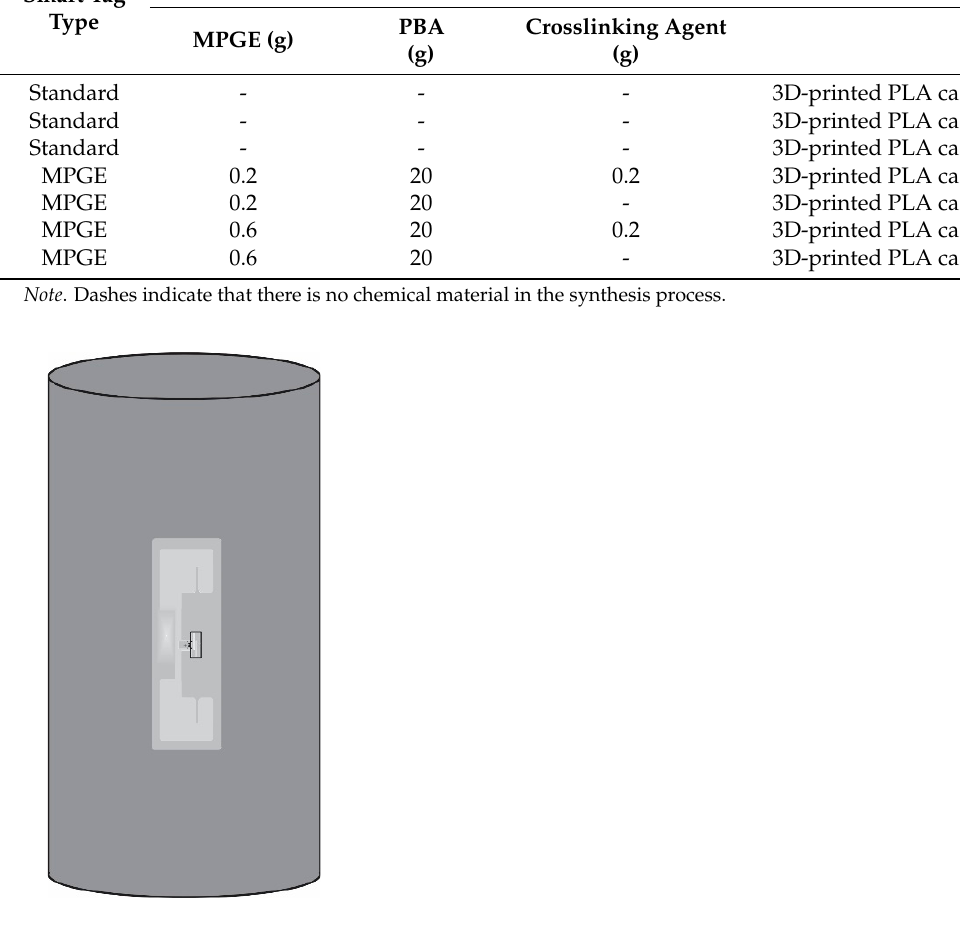
Figure 6. Schematic diagram of the 3D-printed protection of smart sensor tag embedded in Figure 6. Schematicdiagramofthe3D-printedprotectionofsmartsensortagembeddedincylindricalconcrete. cylindrical concrete.